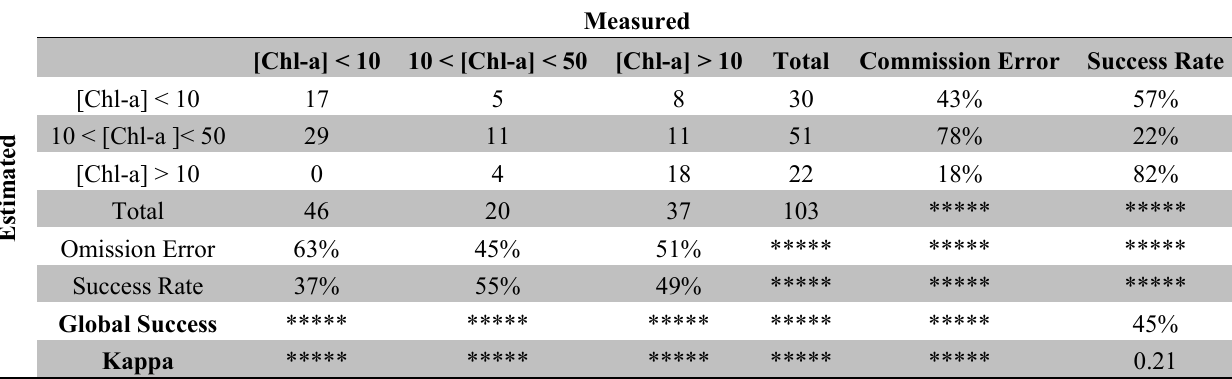
Table 6. The APPEL confusion matrix results.